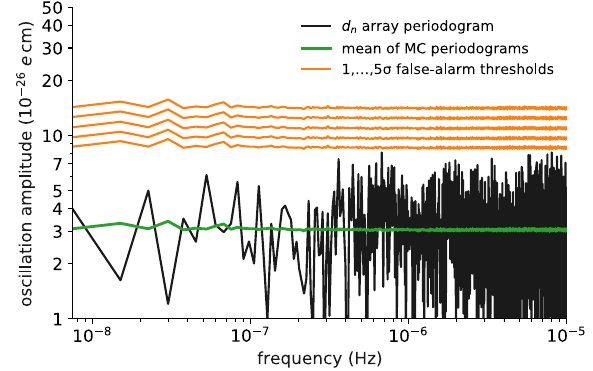
) FIG. 2. The 95% C.L. limits on the amplitude of oscillation in n − ð μ Þ d = μ the quantity d , as a function of frequency n n Hg Hg − ð μ Þ d = μ thereof. The limits from the long-time-base (ILL data) and , where n n Hg Hg short-time-base (PSI data) analyses are depicted by the red and blue curves, respectively, with the area above these curves being excluded. The raw limits delivered by the analysis, with substantial noise, are depicted by the light lines, while the smoothed versions are given in